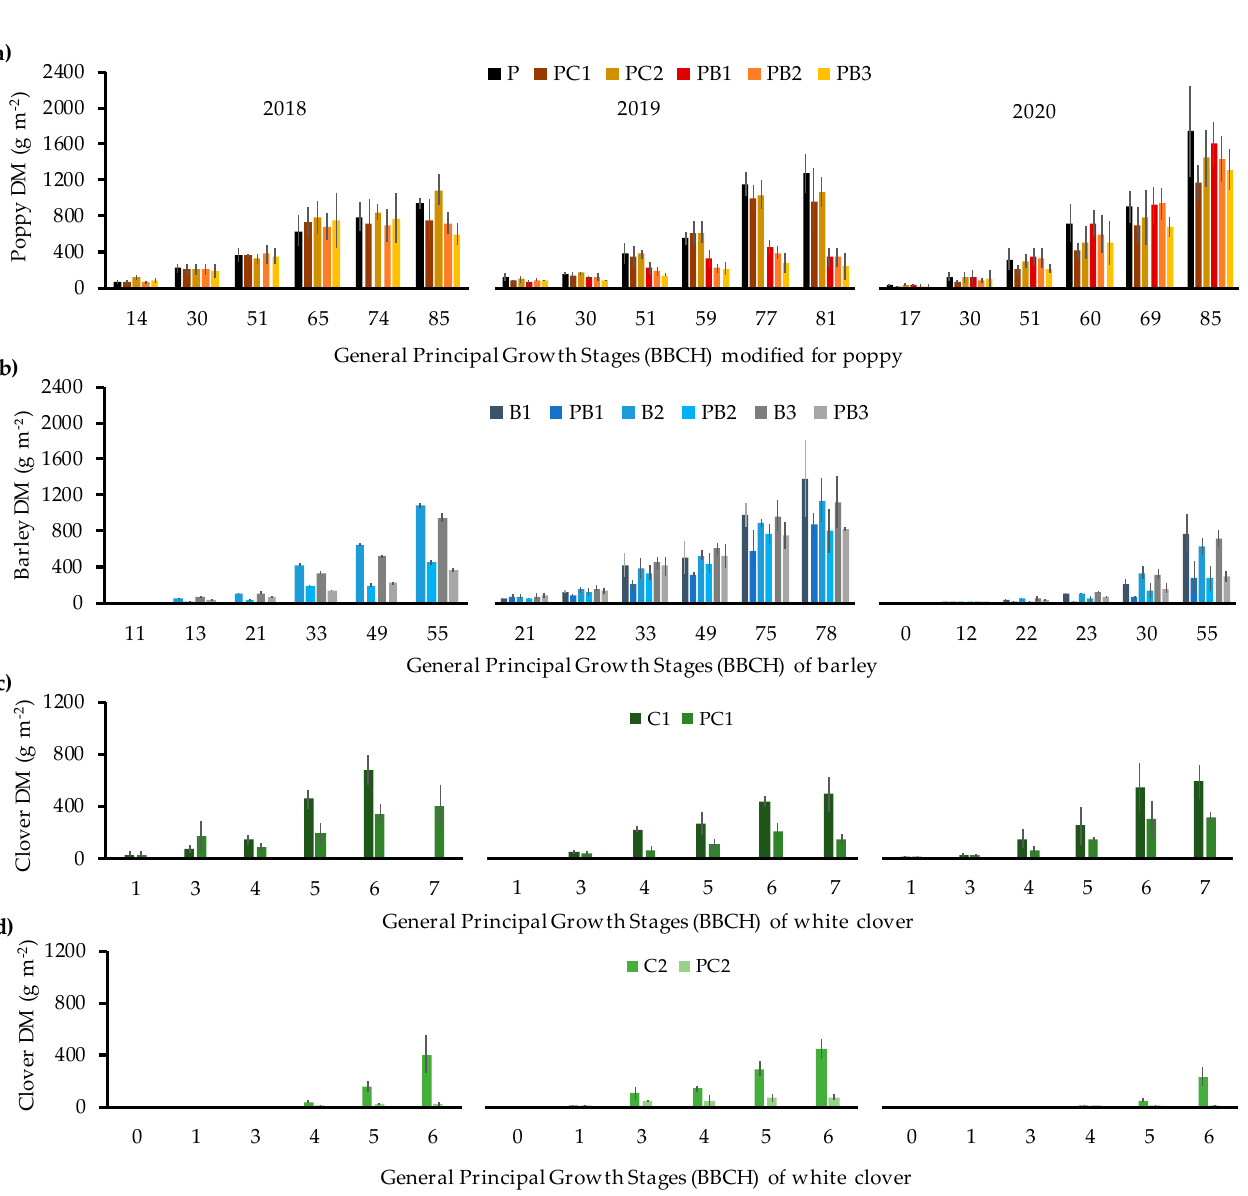
Figure 4. Dry matter (g m − 2 ) of ( a ) poppy, ( b ) barley, ( c ) early sown clover and ( d ) late sown clover as sole crops (P, B1, B2, B3, C1, C2), in poppy–barley intercropping (PB1, PB2, PB3) and poppy-white clover intercropping (PC1, PC2). Detailed descriptive and inferential statistics can be found in Tables S3–S5.